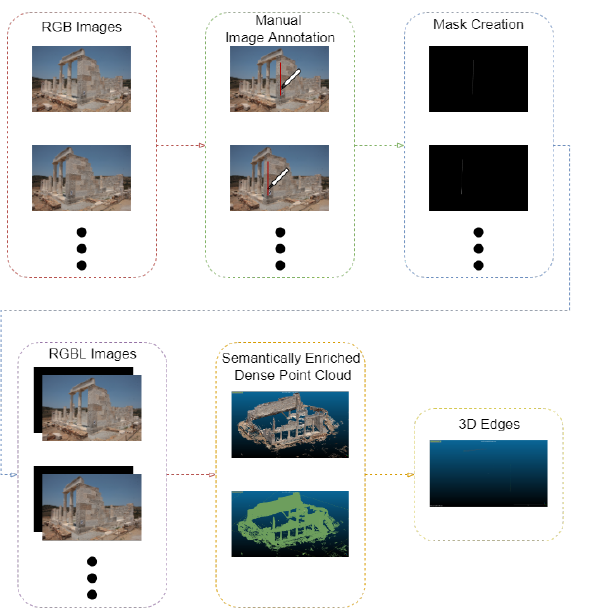
Figure 2. The proposed method